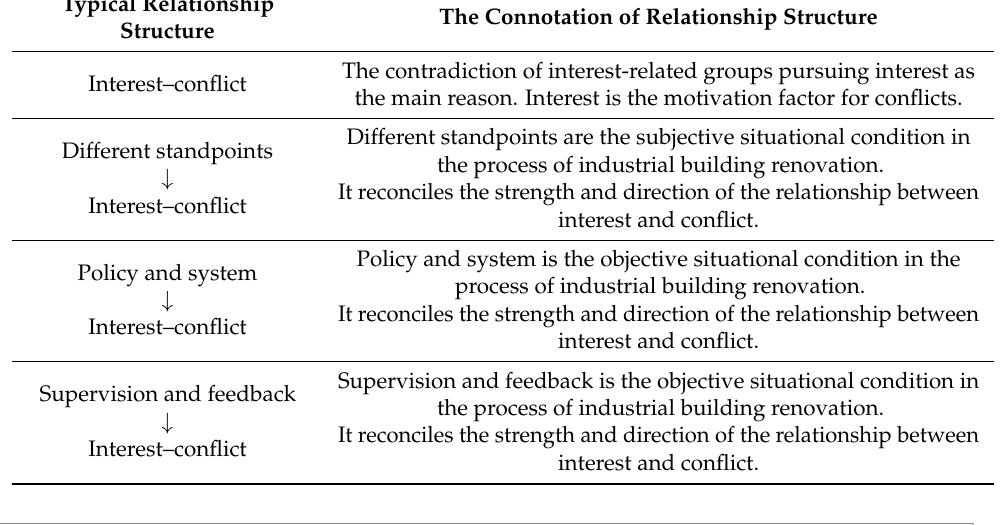
Table 4. Typical relationship structure of the main categories.